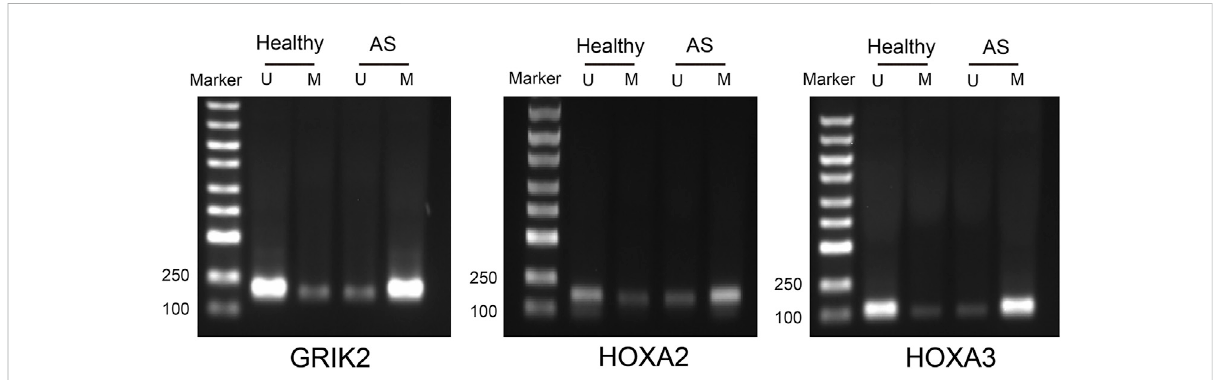
FIGURE 5 Methylation-speci fi c PCR detection of the methylation statuses in the CpG islands of the promoter regions in atherosclerosis and healthy samples. U, un-methylated; M, methylated.